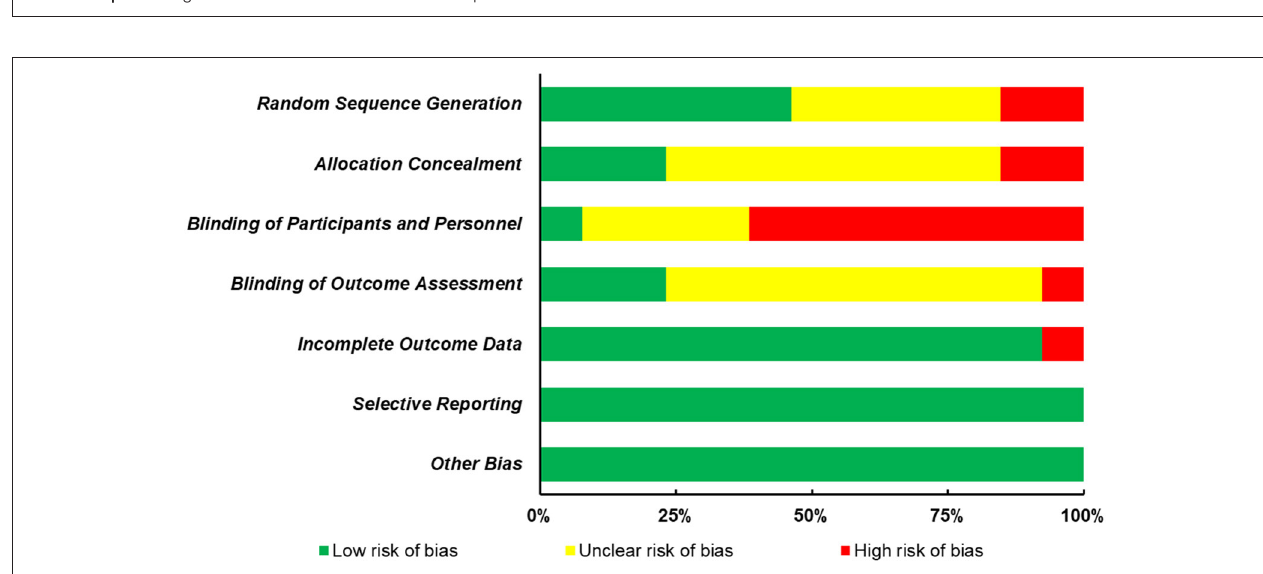
FIGURE 1 | Flow diagram of literature search and selection process.